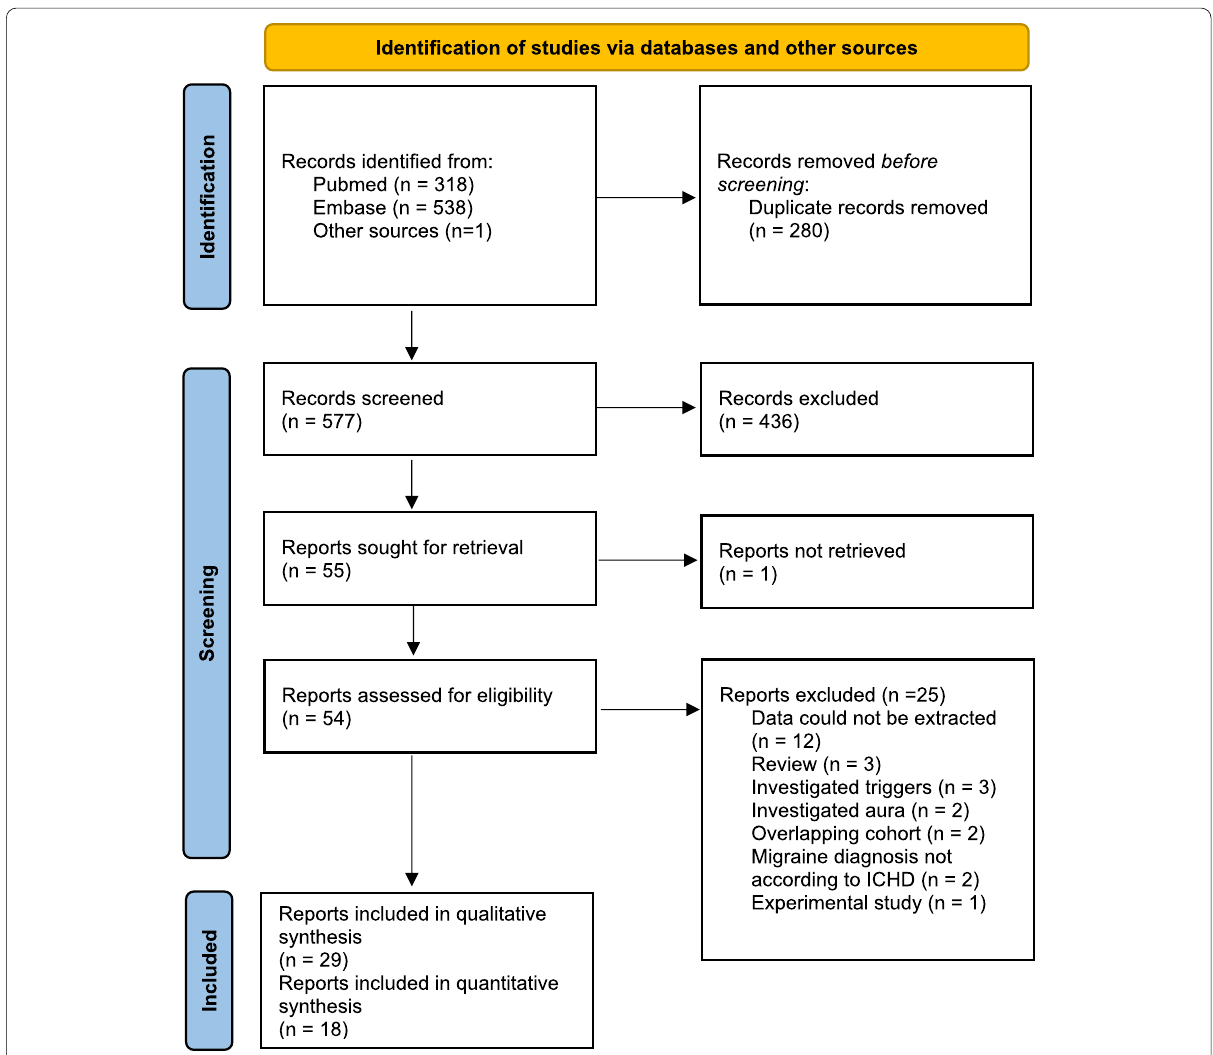
Fig. 1 Preferred Reporting Items for Systematic and Meta-analyses (PRISMA) reporting guideline